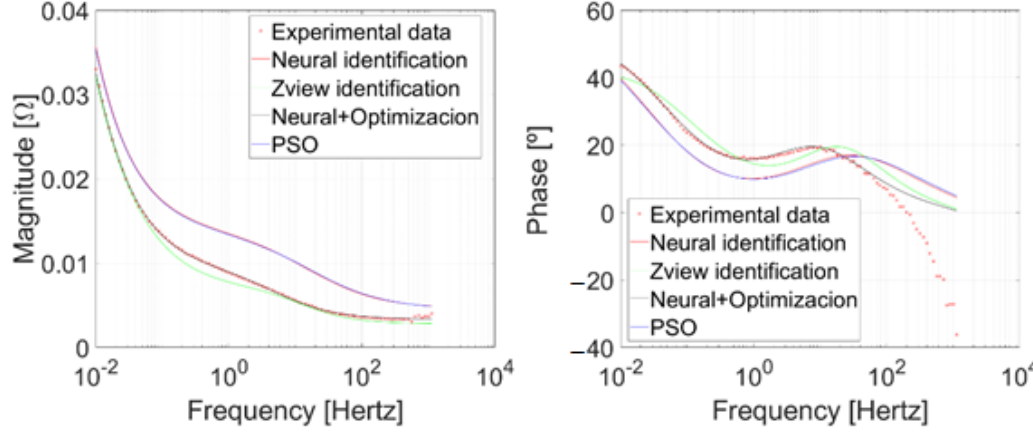
Figure 11. Bode diagrams of final results and comparison with the experimental data .